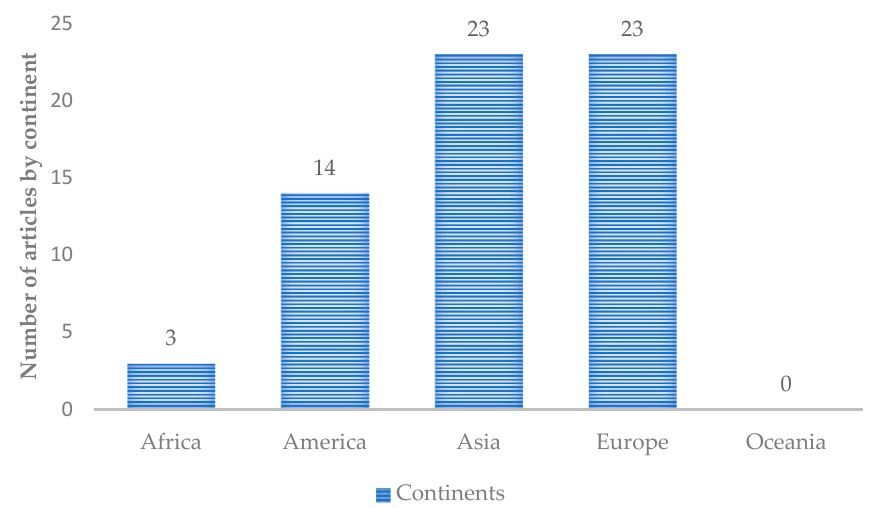
Figure 3. Graph showing the number of publications by continent. Source: authors, 2022.